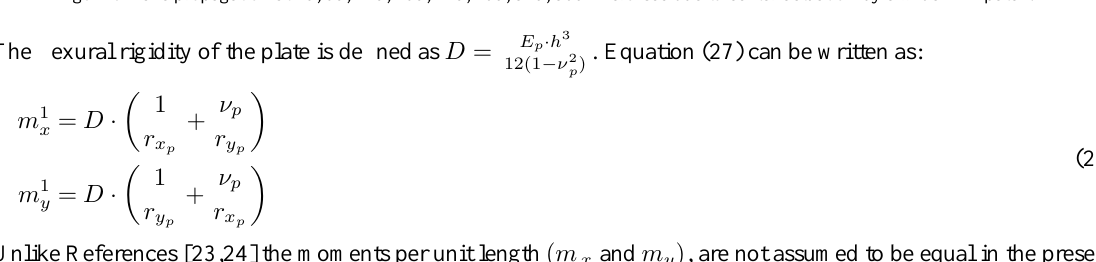
Fig. 11. Wave propagation at 10, 60, 110, 160, 210, 260, 310, 360 micro-sec due to center actuation by a wide PZT